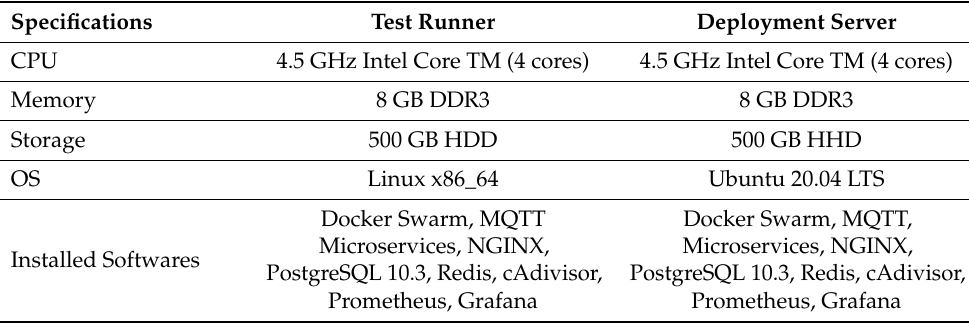
Table 4. Specifications of environments used for performance